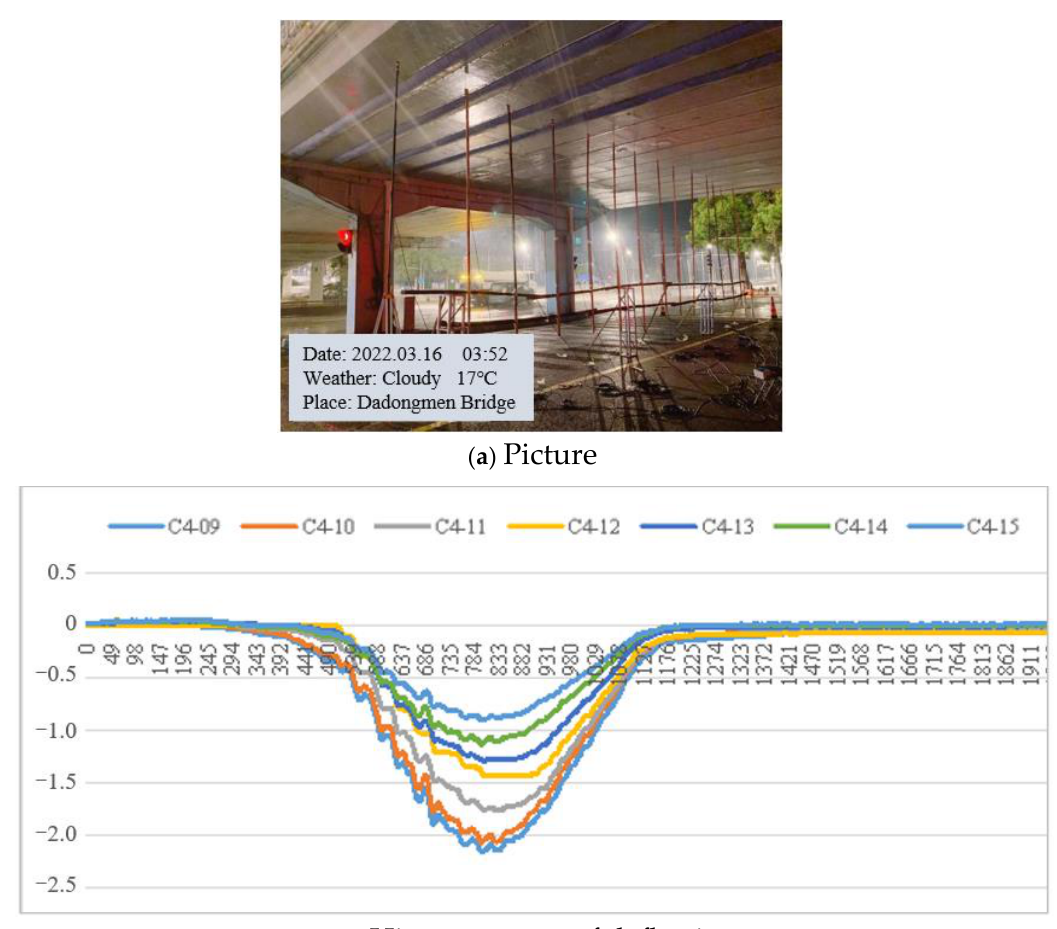
( b ) History curves of deflection Figure 6. Deflection measurement. Figure 6. Deflection